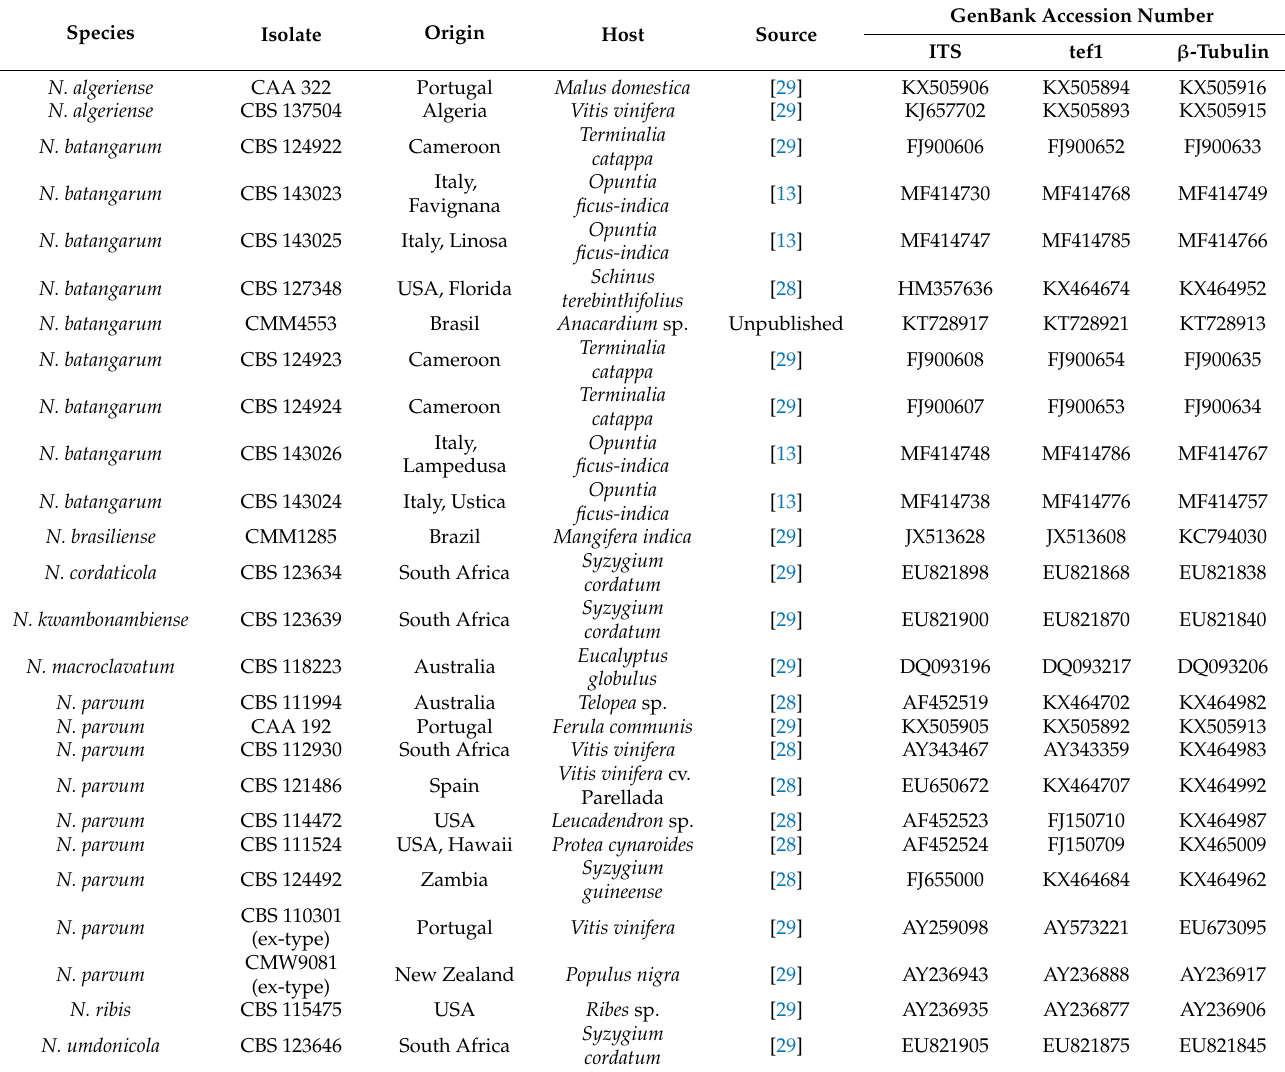
Table 2. GenBank accession numbers of sequences of Neofusicoccum spp. isolates of different geographical and host origins used as reference in phylogenetic